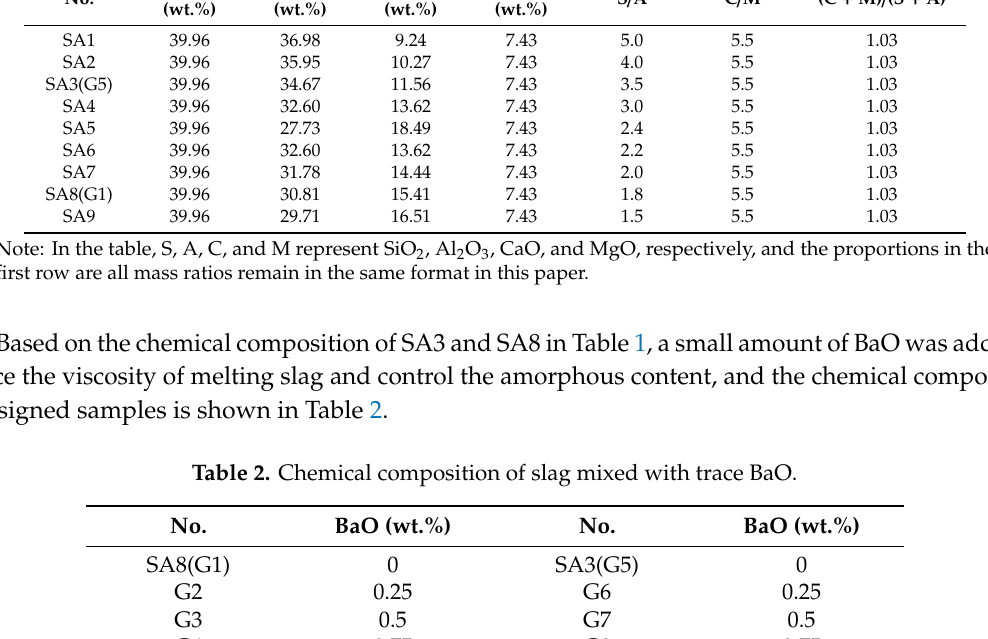
Table 1. Chemical composition of slag with di ff erent proportions of network former. CaO SiO 2 Al 2 O 3 No. (wt.%) (wt.%) (wt.%)